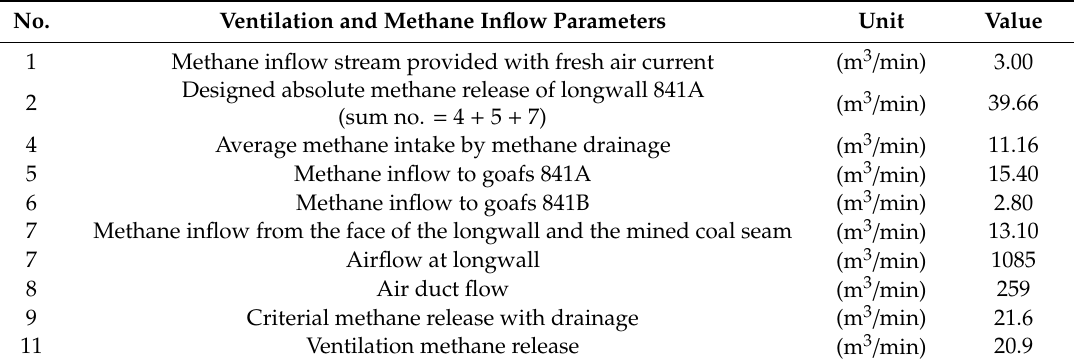
Table 1. Determination of the methane release for longwall